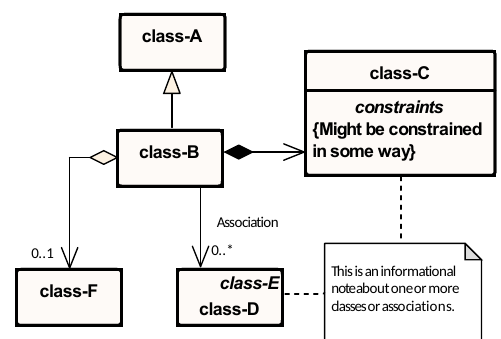
Figure A1. A worked example demonstrating the subset of UML used in this paper (see Table 1 for definitions of the class associ- ations). Class-B is a subclass of class-A, and class-D is subclass of class-E. An instance of class-B includes one instance of class- C (that cannot exist independently) and may include zero or one instance(s) of class-F (that can exist independently). An instance of class-B is related to any number of instances of class-D (with the relationship being described by the label “Association”). An in- stance of class-C is constrained to exhibit some behaviour. There is a general comment concerning class-D and